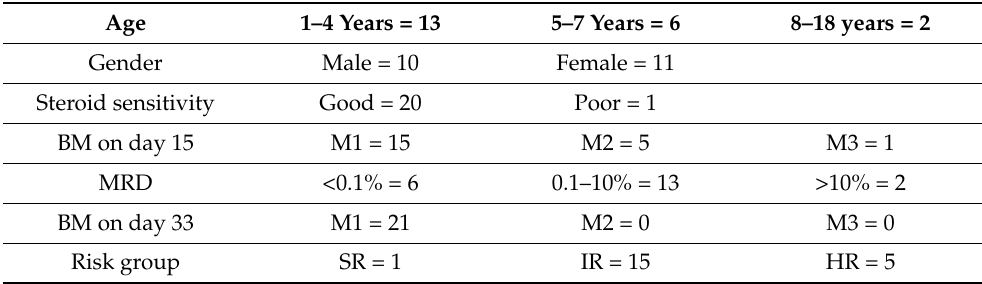
Table 1. Patient